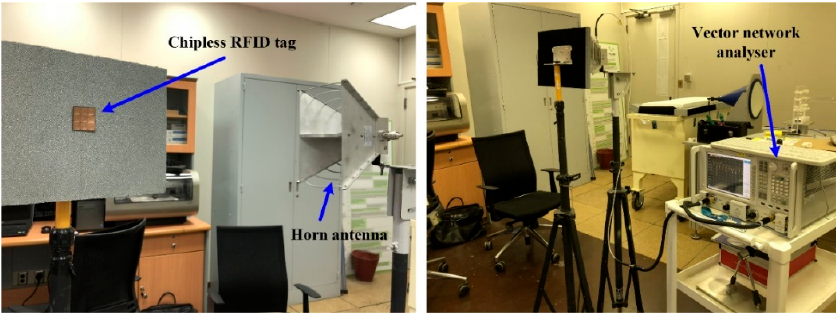
Figure 14. Measurement setup outside the anechoic chamber.